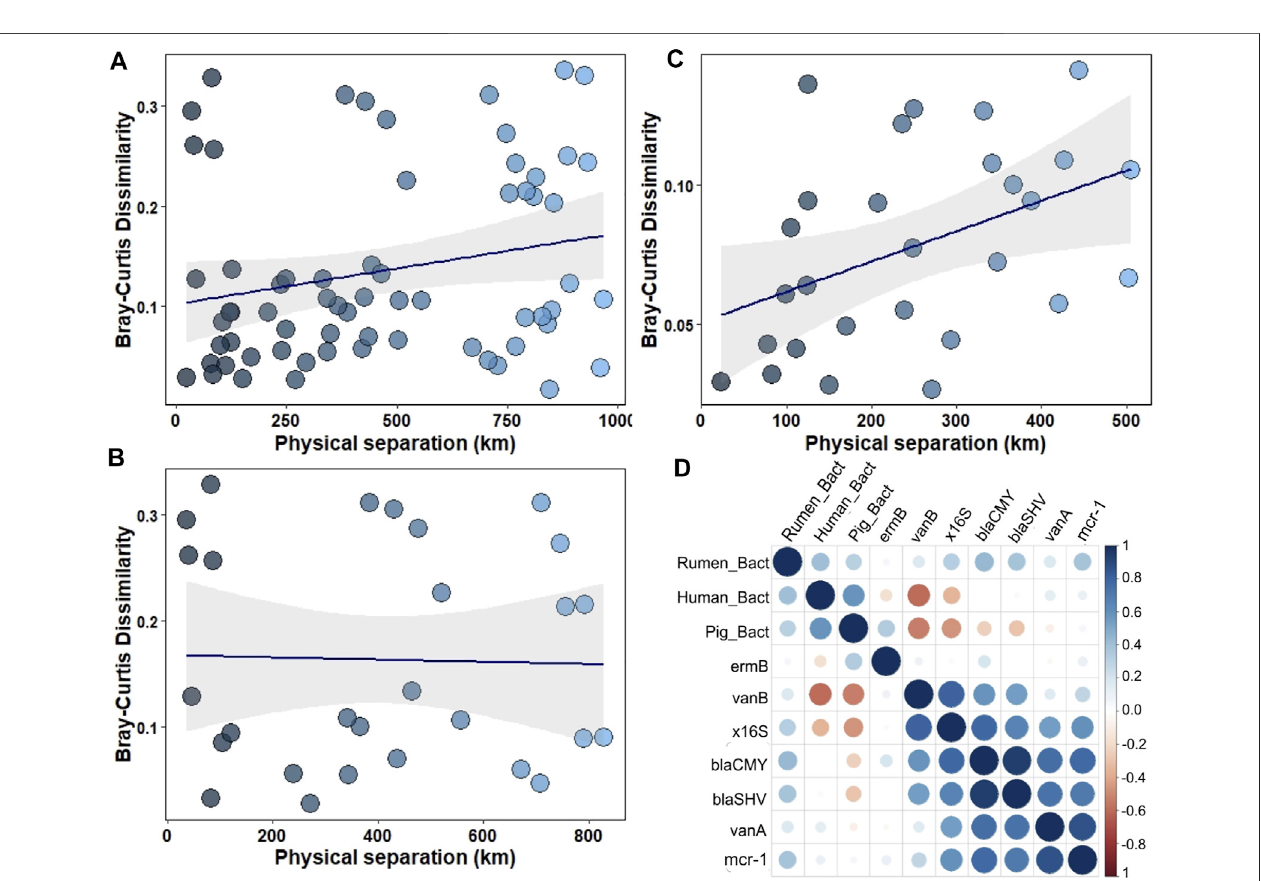
FIGURE 3 | (A – C) Variance of faecal pollution dependent on the physical separation of the samples: (A) within the northwest shelf — eastern shelf segment (from station1Atostation12); (B) — withintheopenwaters — easternshelfsegment(fromstation4tostation12); (C) — withinthenorthwestshelf — openwaterssegment(from station 1A to station 8); (D) — Spearman correlation between ARGs ’ number and number of faecal pollution markers.